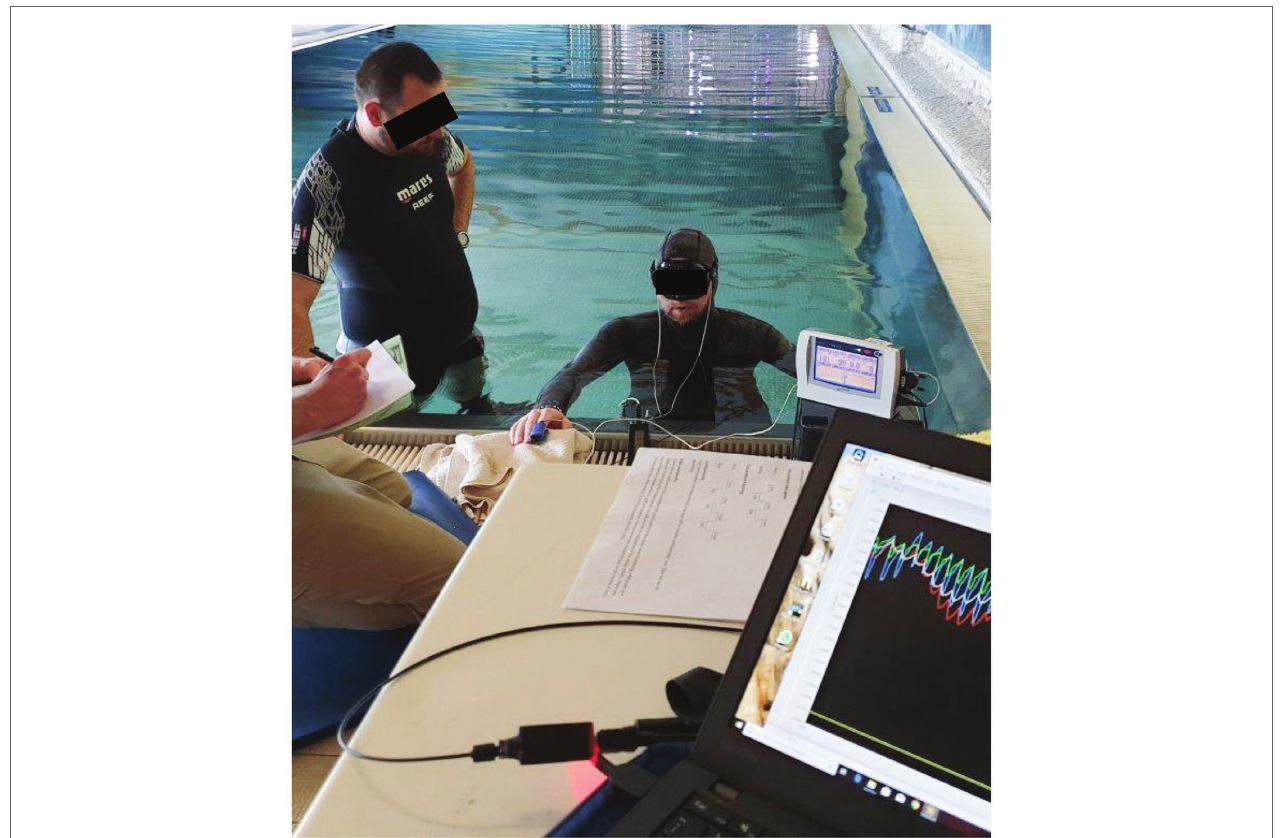
FIGURE 4 | The static apnea test with the diver immersed near the surface of a